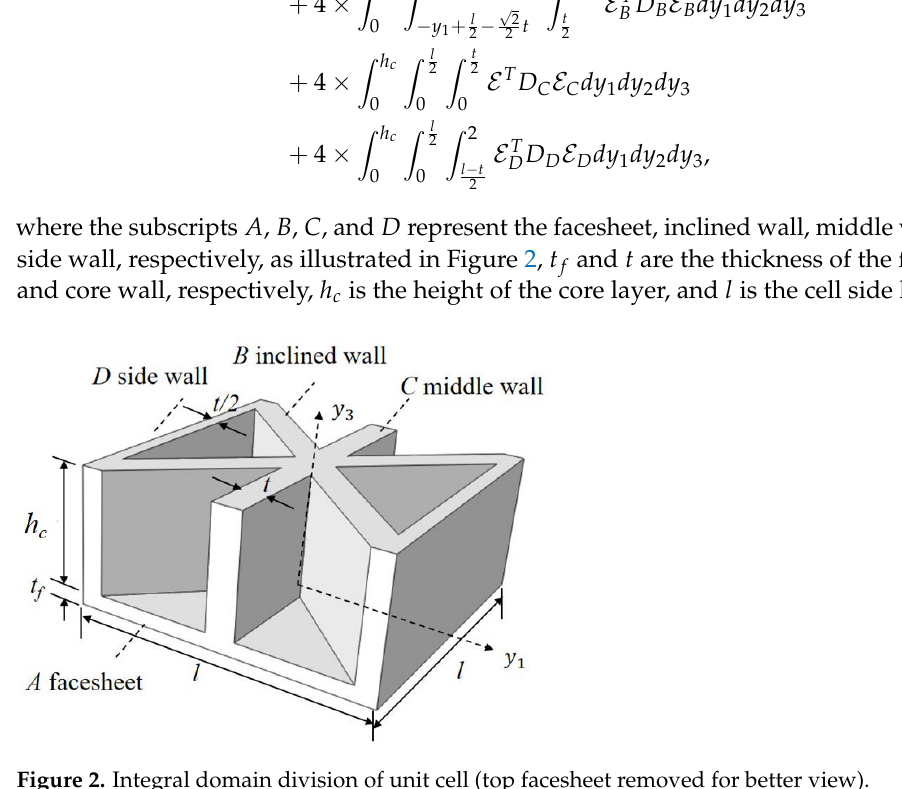
Figure 2. Integral domain division of unit cell (top facesheet removed for better